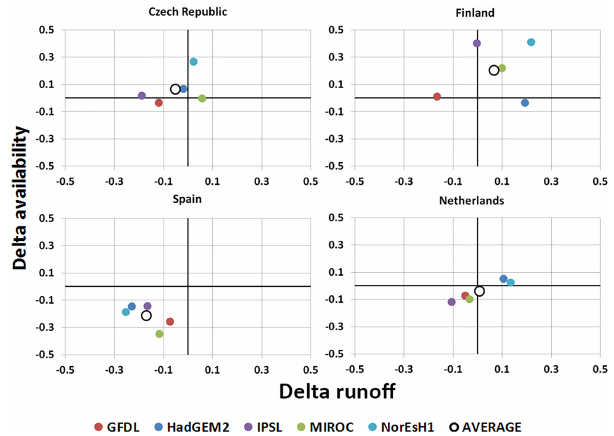
Figure 6. Changes in annual runoff versus water availability for the model ensemble average (circles) and the individual GCMs (coloured dots) for RCP4.5 long